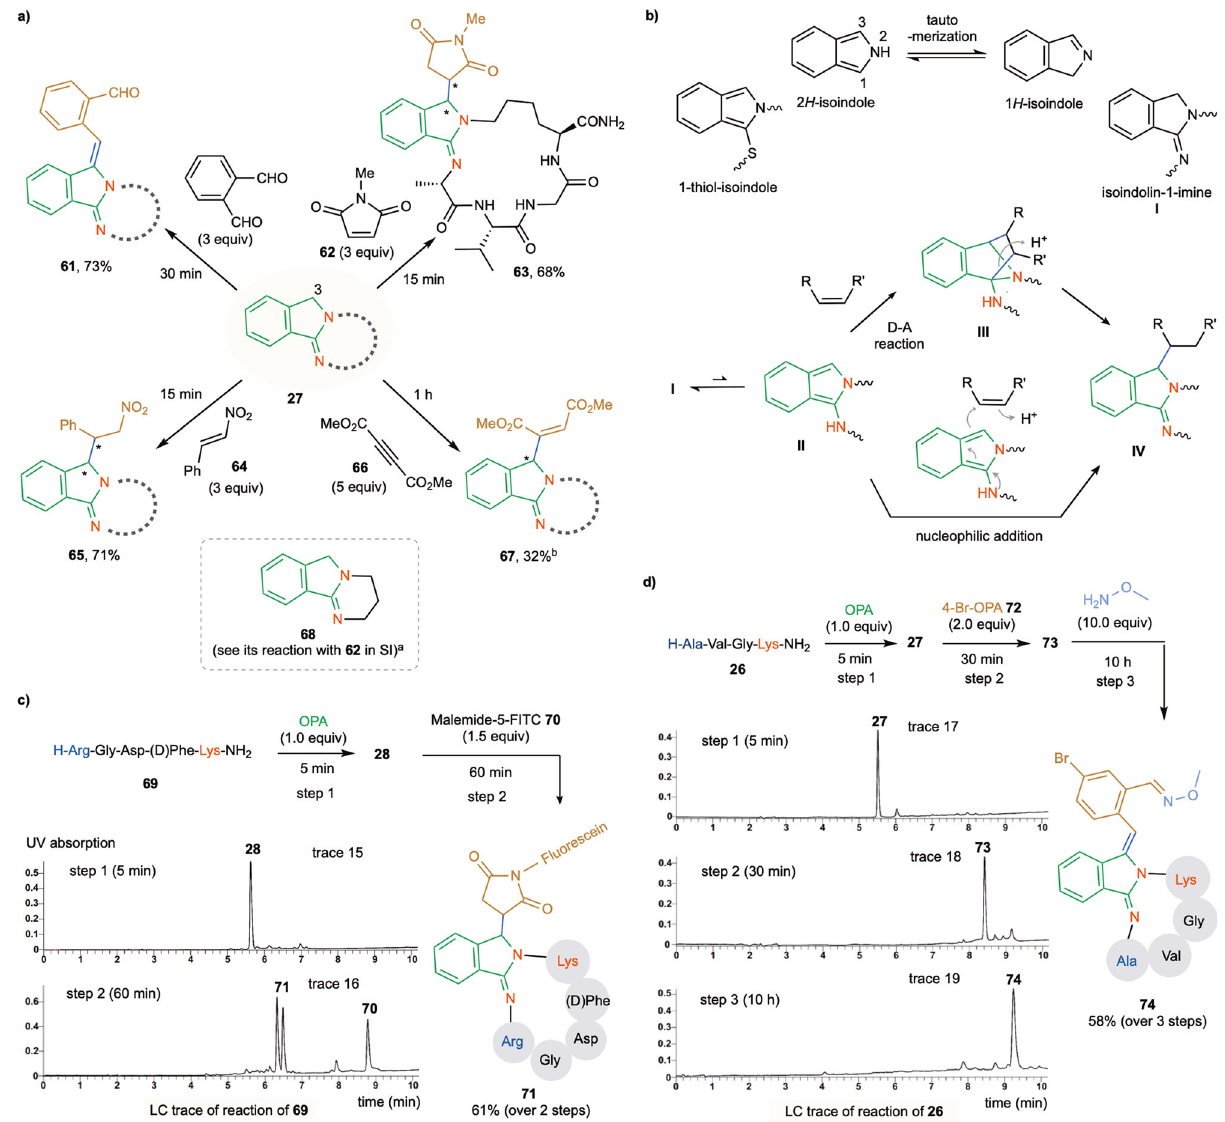
Fig. 5 Facile extension of stapled product with electron-de fi cient π electrophiles. All reactions were conducted under condition [ C ] (H 2 O/TFE (1:1), DIPEA, rt) at 5.0 mM concentration. a Extension of 27 . Isolated yield over two steps in one pot. Stereochemistry of the double modi fi cation products has not been determined. b Possible reaction pathways of the isoindolin-1-imine moiety. c Fluorescent labeling of 69 via double modi fi cation in one pot. d Triple modi fi cation of 25 via sequential additions in one pot. a See Supplementary Figures 51 – 54 for a detailed analysis of the reaction of model substrate 68 with 62 . The uncapped N-terminal AA units are marked in ocean blue, the lysine units and amino groups are marked in red, the OPA reagent and isoindolinimine core are marked in green, and the linkages between isoindolinimine and electrophiles are marked in